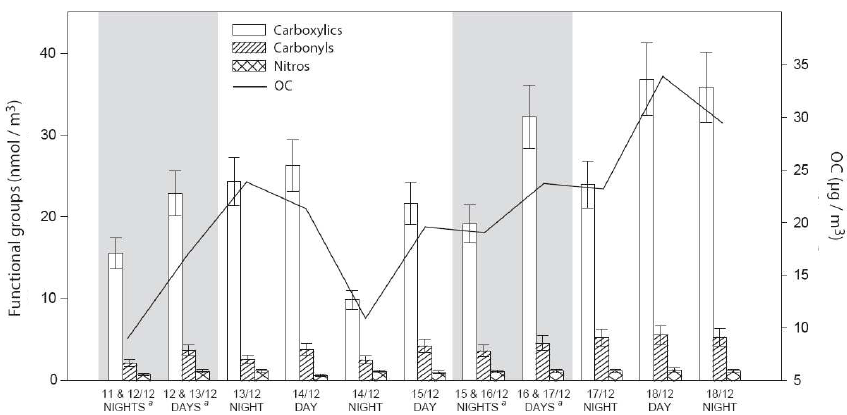
Fig. 2. Carboxylic, carbonyl and nitro functional groups and OC atmospheric concentrations during the Chamonix sampling campaign, in December 2007. The filters were collected following night (18:00h to 06:00h local time) and day periods (06:00h to 18:00h local time). Error bars represent the analytical deviations. The grey backgrounds outline the samples also used for determination of organic tracers. Error bars correspond to the analytical RSD (carboxylics: 12%, carbonyls: 20%, nitros: 20%). a Composite samples of the filters collected at the indicated dates, see text for details (Sect. 2.1.3).